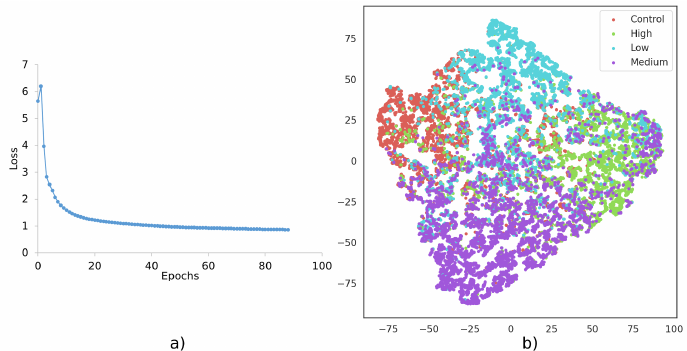
Figure 12. ( a ) is the loss converge trend on self-supervised learning, ( b ) is t-SNE visualization of the model trained with the proposed SSL.